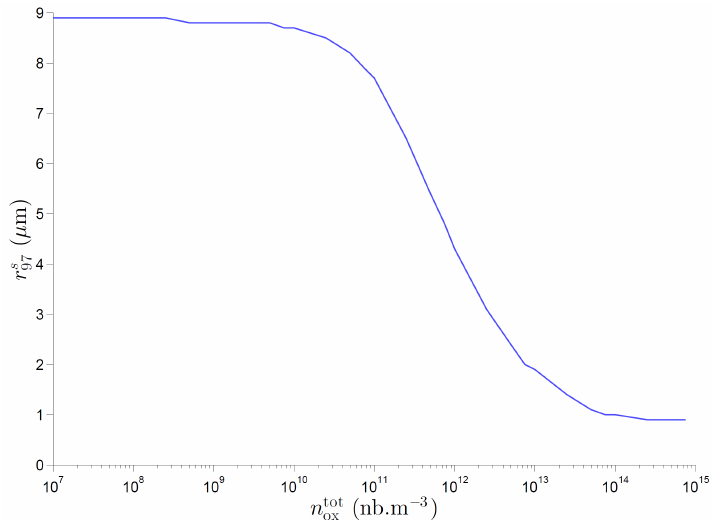
Figure 7. Influence of the oxide density on the size of largest inclusions in the solid phase. ( ω N = 10 ppm, t s = 1000